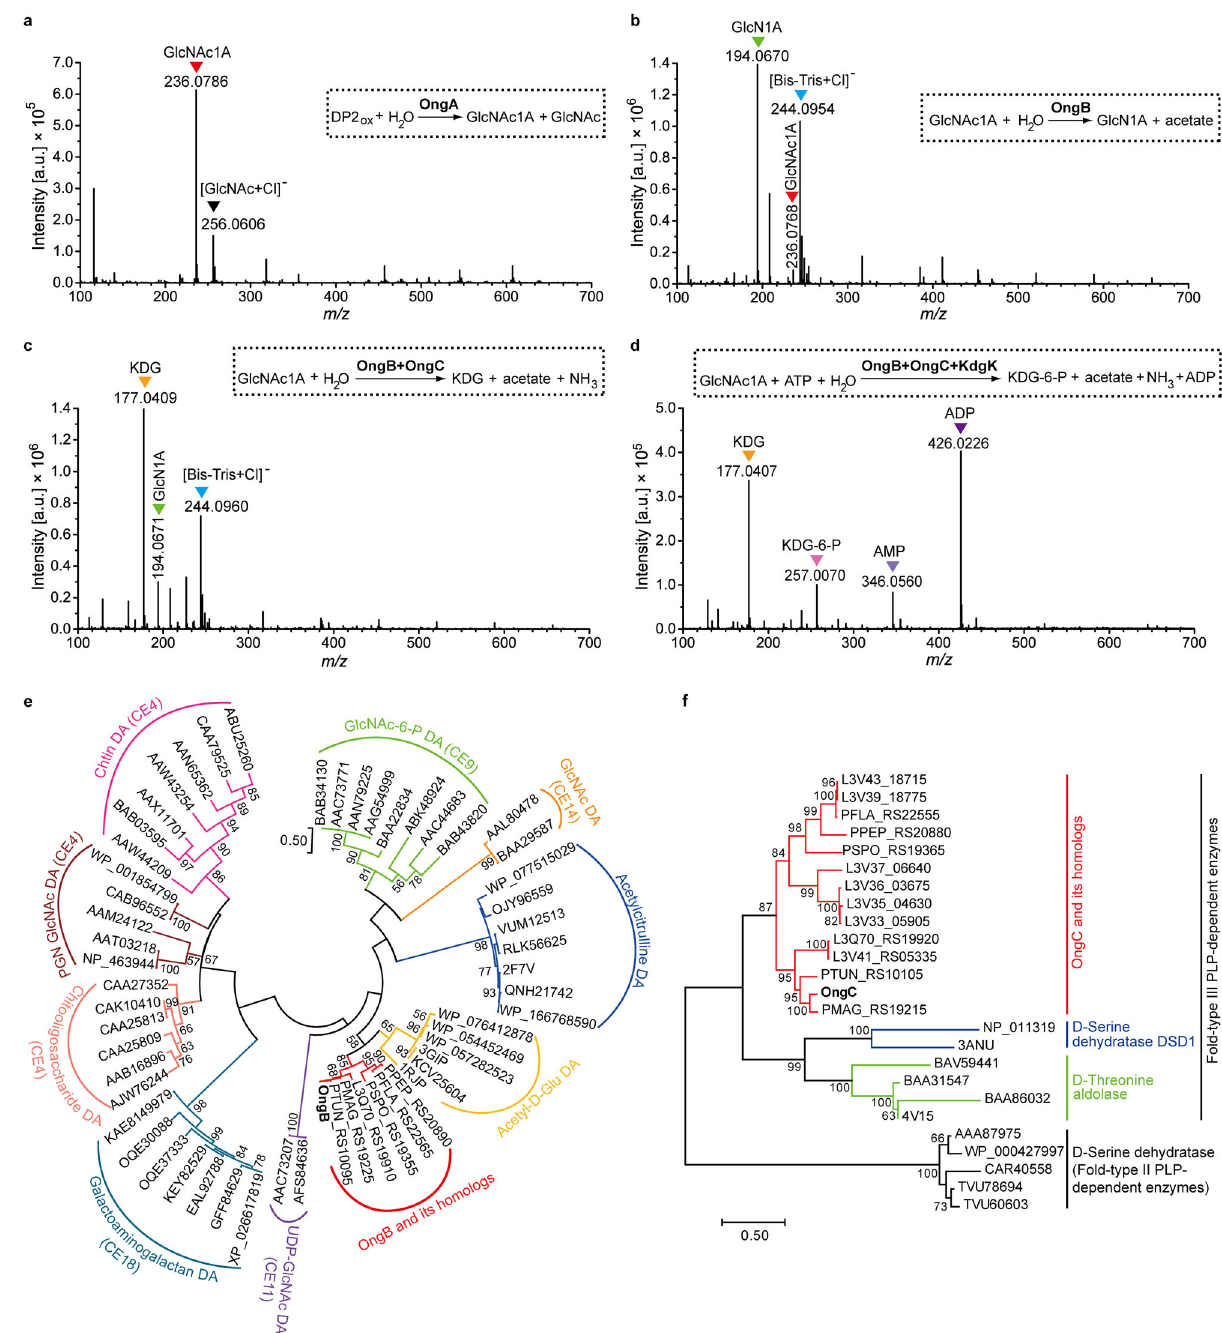
Fig.4|InvitrobiochemicalanalysesofenzymesOngA,OngB,OngCandKdgK. a Negative-mode Q-TOF-MS spectrum of products generated by the recombinant OngA acting on GlcNAc-GlcNAc1A. Q-TOF-MS spectrum of GlcNAc-GlcNAc1A only as the control was shown in Supplementary Fig. 12a. DP2 ox , GlcNAc-GlcNAc1A. b Negative-mode Q-TOF-MS spectrum of products generated by the recombinant OngBactingonGlcNAc1A.Q-TOF-MSspectrumofGlcNAc1Aonlyasthecontrolwas shown in Supplementary Fig. 12b. c Negative-mode Q-TOF-MS spectrum of pro- ducts generated by the recombinant enzymes, OngB and OngC, acting on GlcNAc1A. Q-TOF-MS spectrum of KDG only as the control was shown in Supple- mentary Fig. 12c. d Negative-mode Q-TOF-MS spectrum of products generated by OngB, OngC and KdgK successively acting on GlcNAc1A. Q-TOF-MS spectrum of